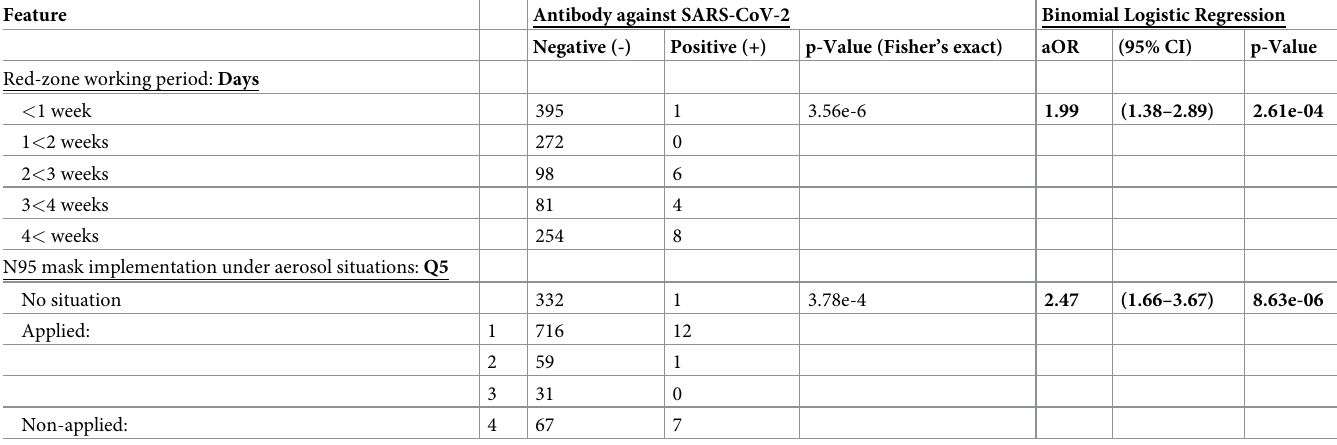
Table 3. The subsequently binomial logistic regression analysis with 2